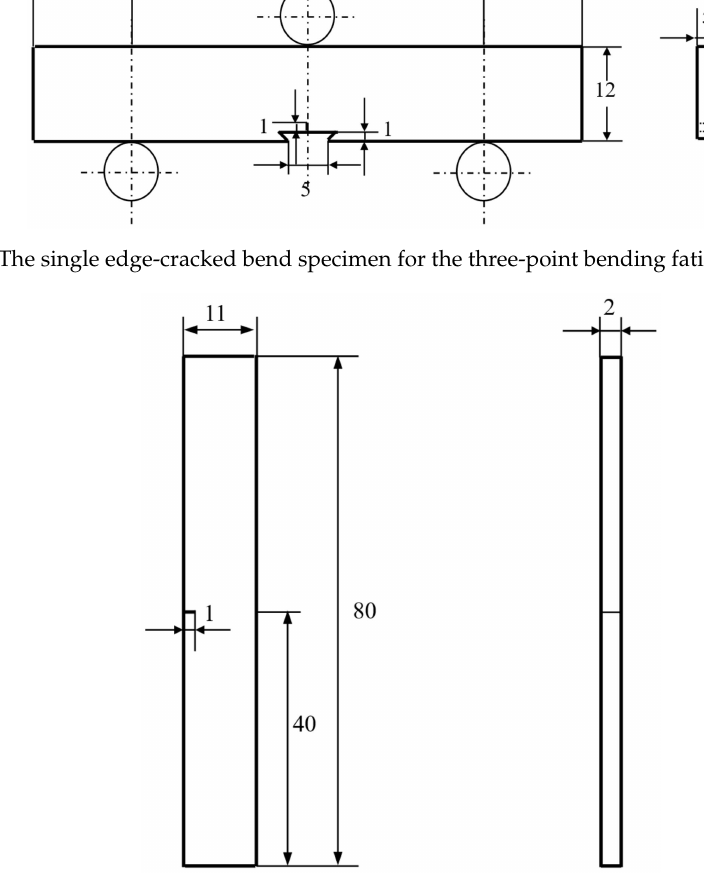
Figure 3. The single edge-cracked tension specimen for fatigue tensile test (unit: